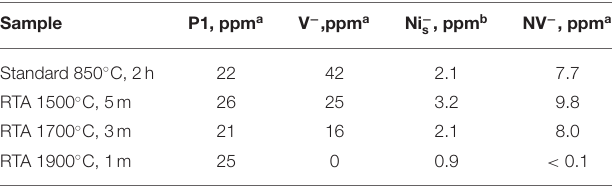
TABLE 1 | Contents of primary ( S = 1/2, 3/2) and triplet ( S = 1) paramagnetic centers for the samples irradiated to the fluence 1.5 × 10 19 e/cm 2 and annealed at different